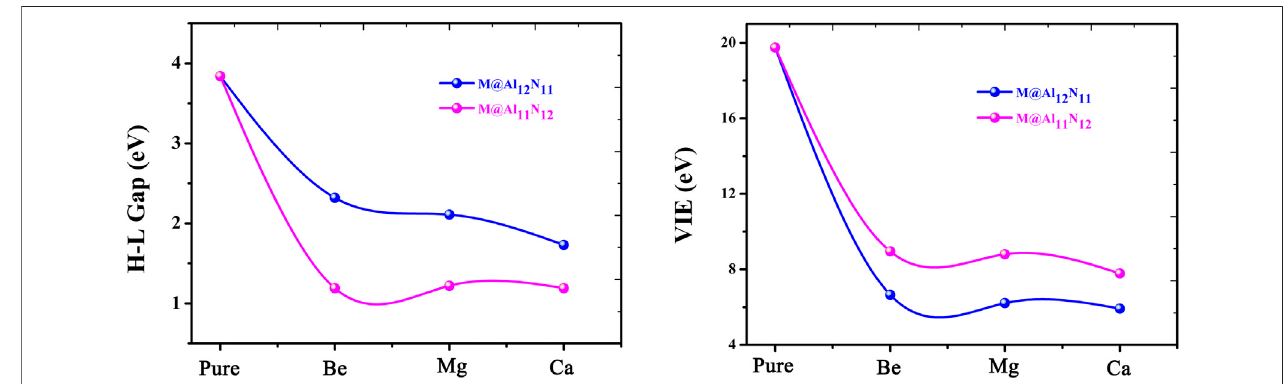
FIGURE 3 | Relationship between H-L Gaps and VIE values with the atomic number of alkaline-earth metals.